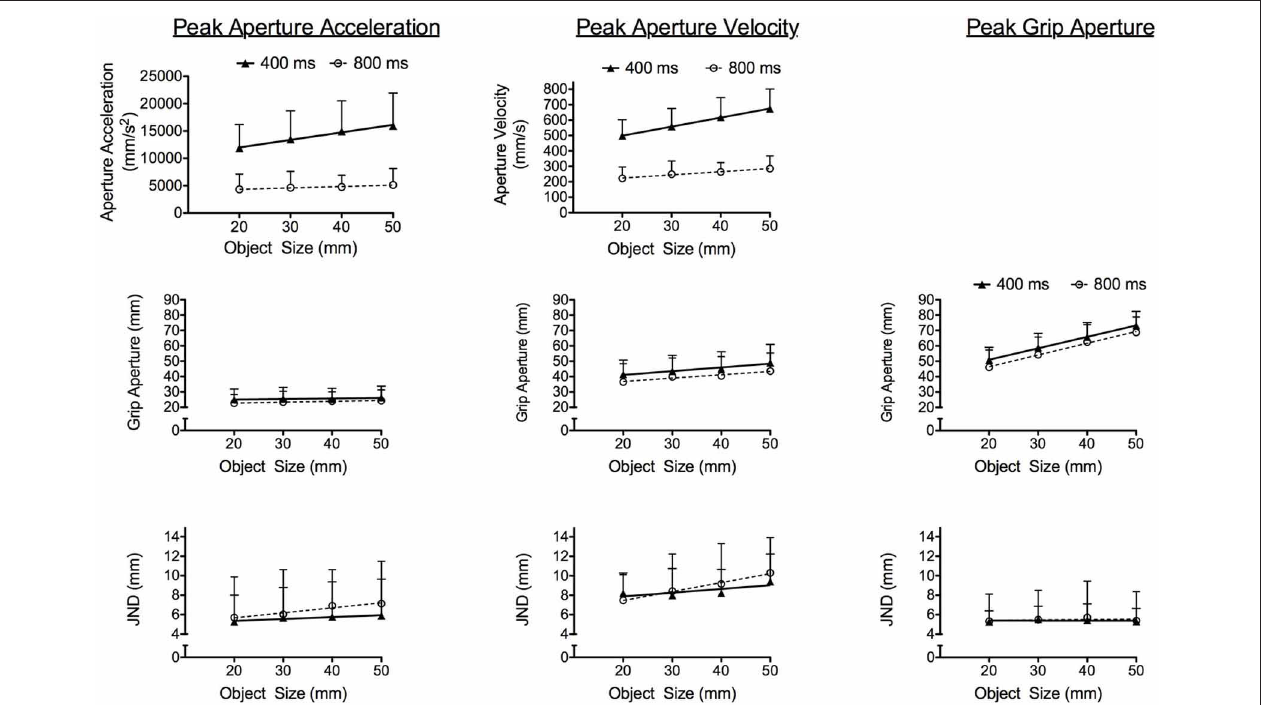
and JNDs (mm). The middle column depicts grip aperture velocity (mm/s) and time-matched aperture size (mm) and JNDs (mm). The right column depicts peak grip aperture (mm) and associated JNDs. A panel is not included at the top right because aperture acceleration and velocity are (by definition) equal to zero at the time of peak grip aperture. Error bars represent between-participant standard deviations.